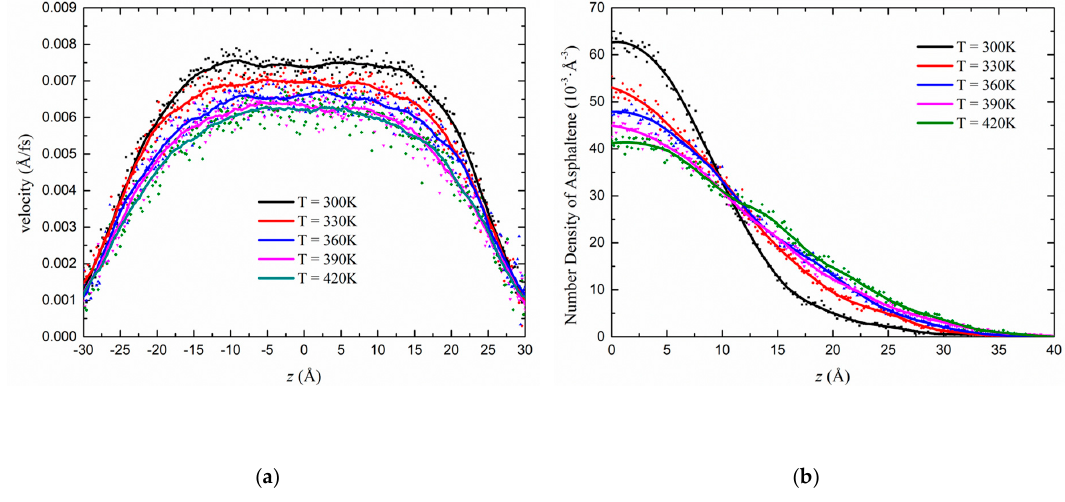
Figure 6. Effect of the Temperature: ( a ) The fluid velocity profiles at different temperatures. ( b ) The asphaltene’s density at different temperatures. F = 30 × 10 -4 kcal/(mol·Å).